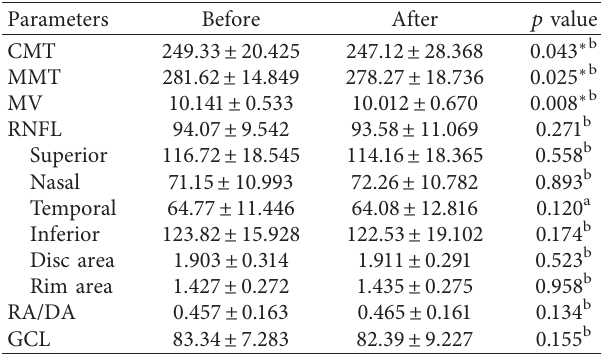
Table 2: Perioperative comparison of macular and optic disc parameters of all eyes.